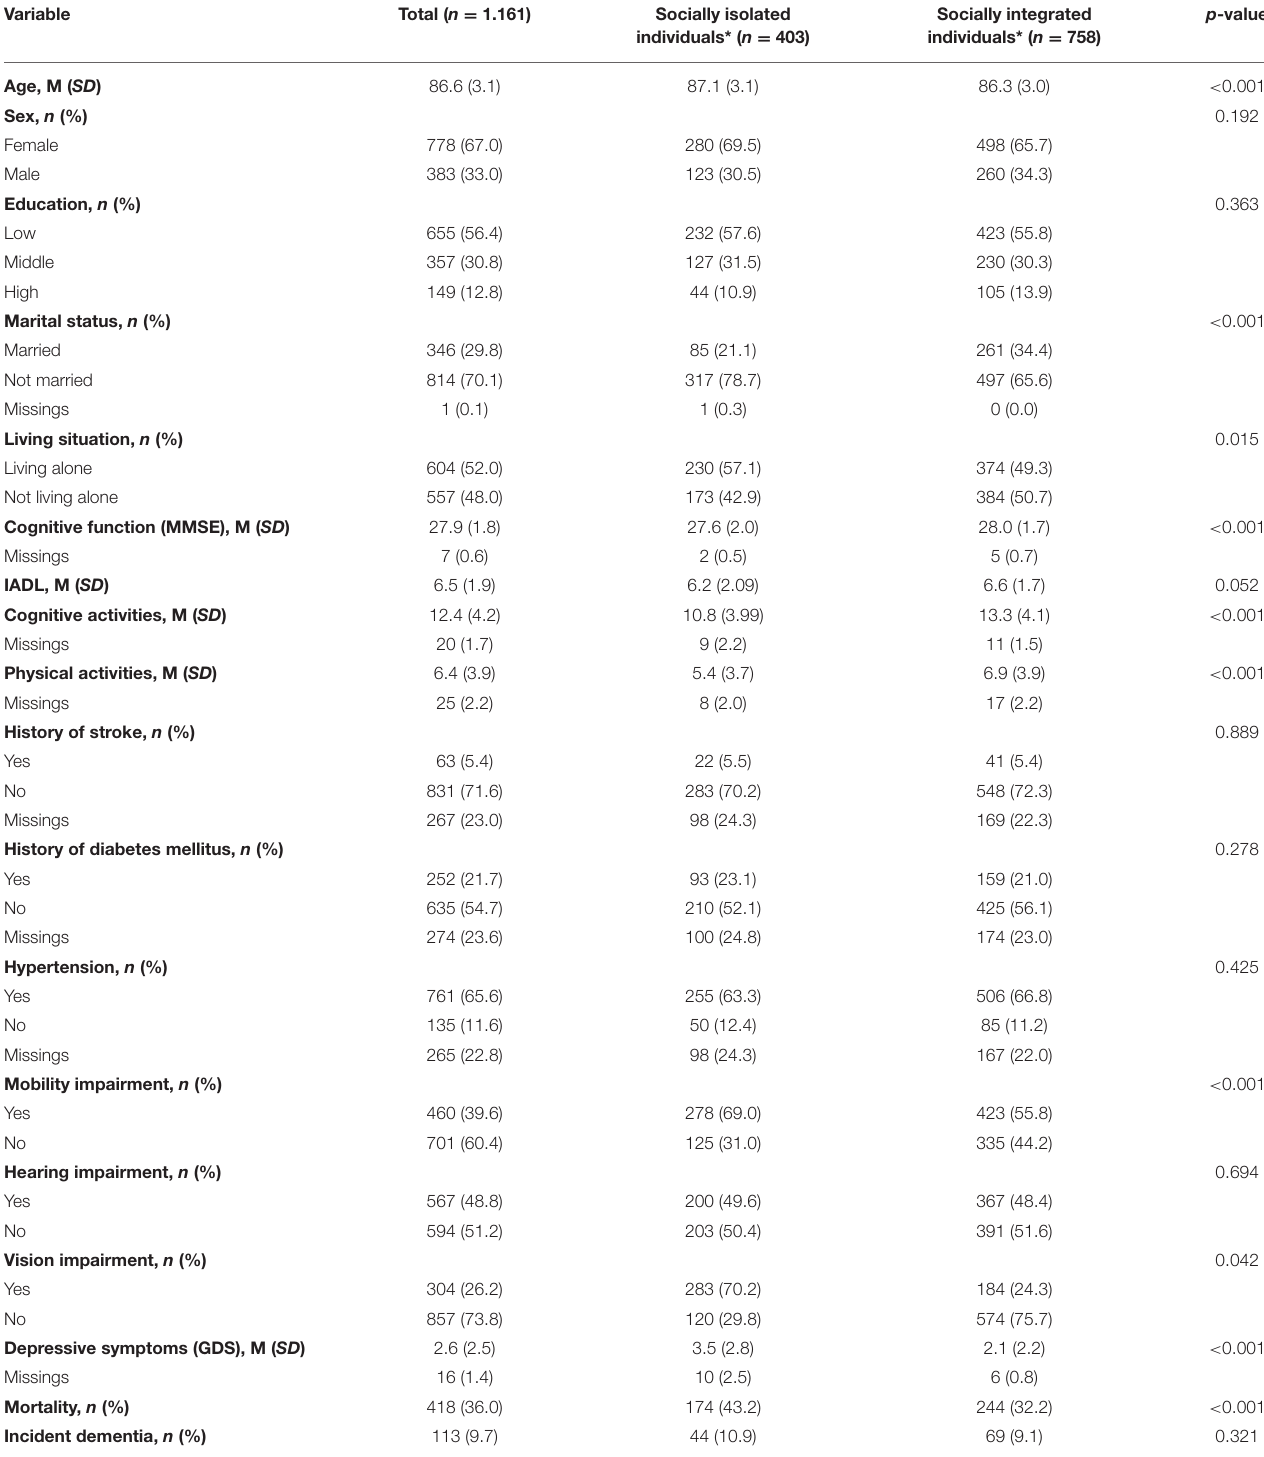
TABLE 1 | Sociodemographic and health characteristics of the study sample.